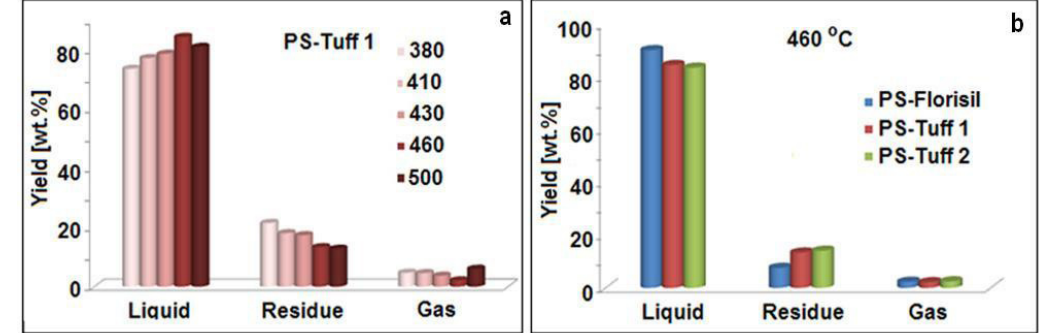
Figure 6. The influences of temperature and catalysts type on yields of products obtained thermal degradation of